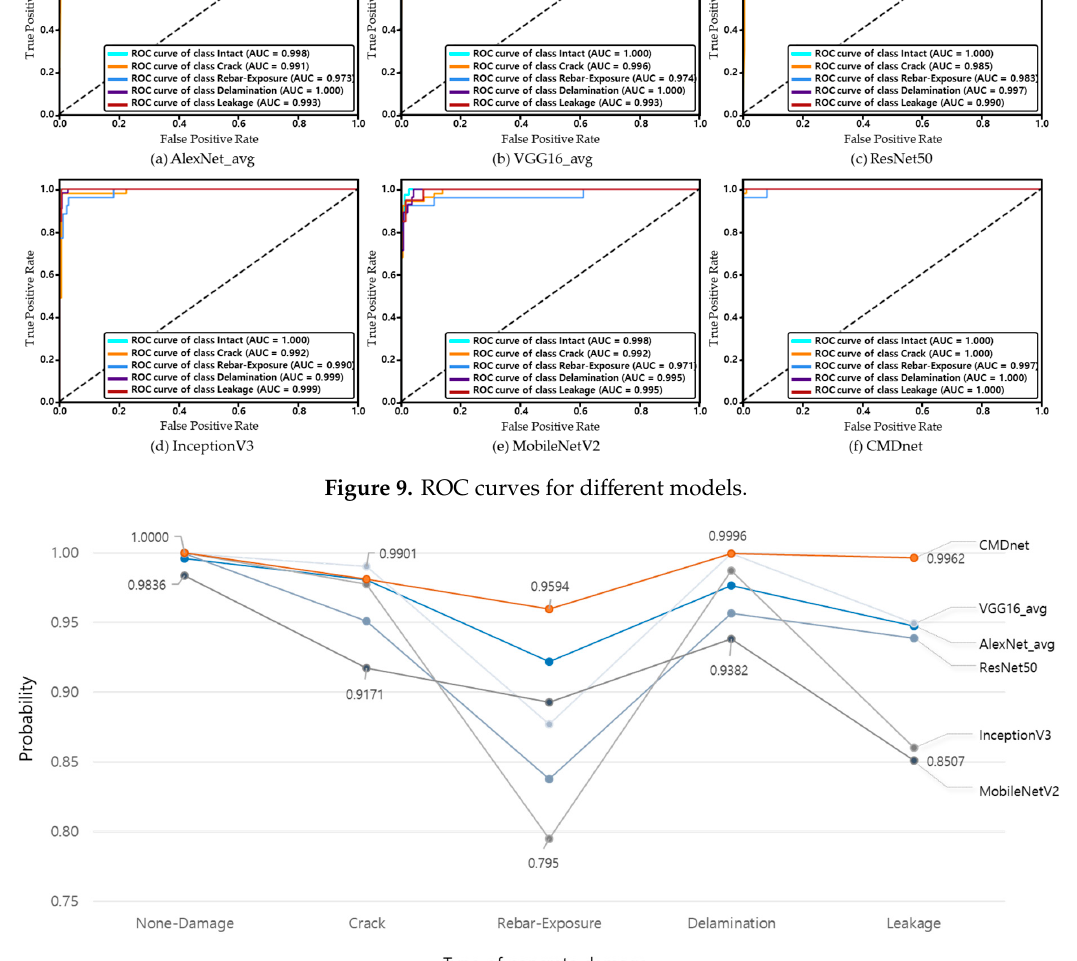
ff erent models according to concrete damage Figure 10. Average prediction probability of different models according to concrete damage type. Figure 10. Average prediction probability of di